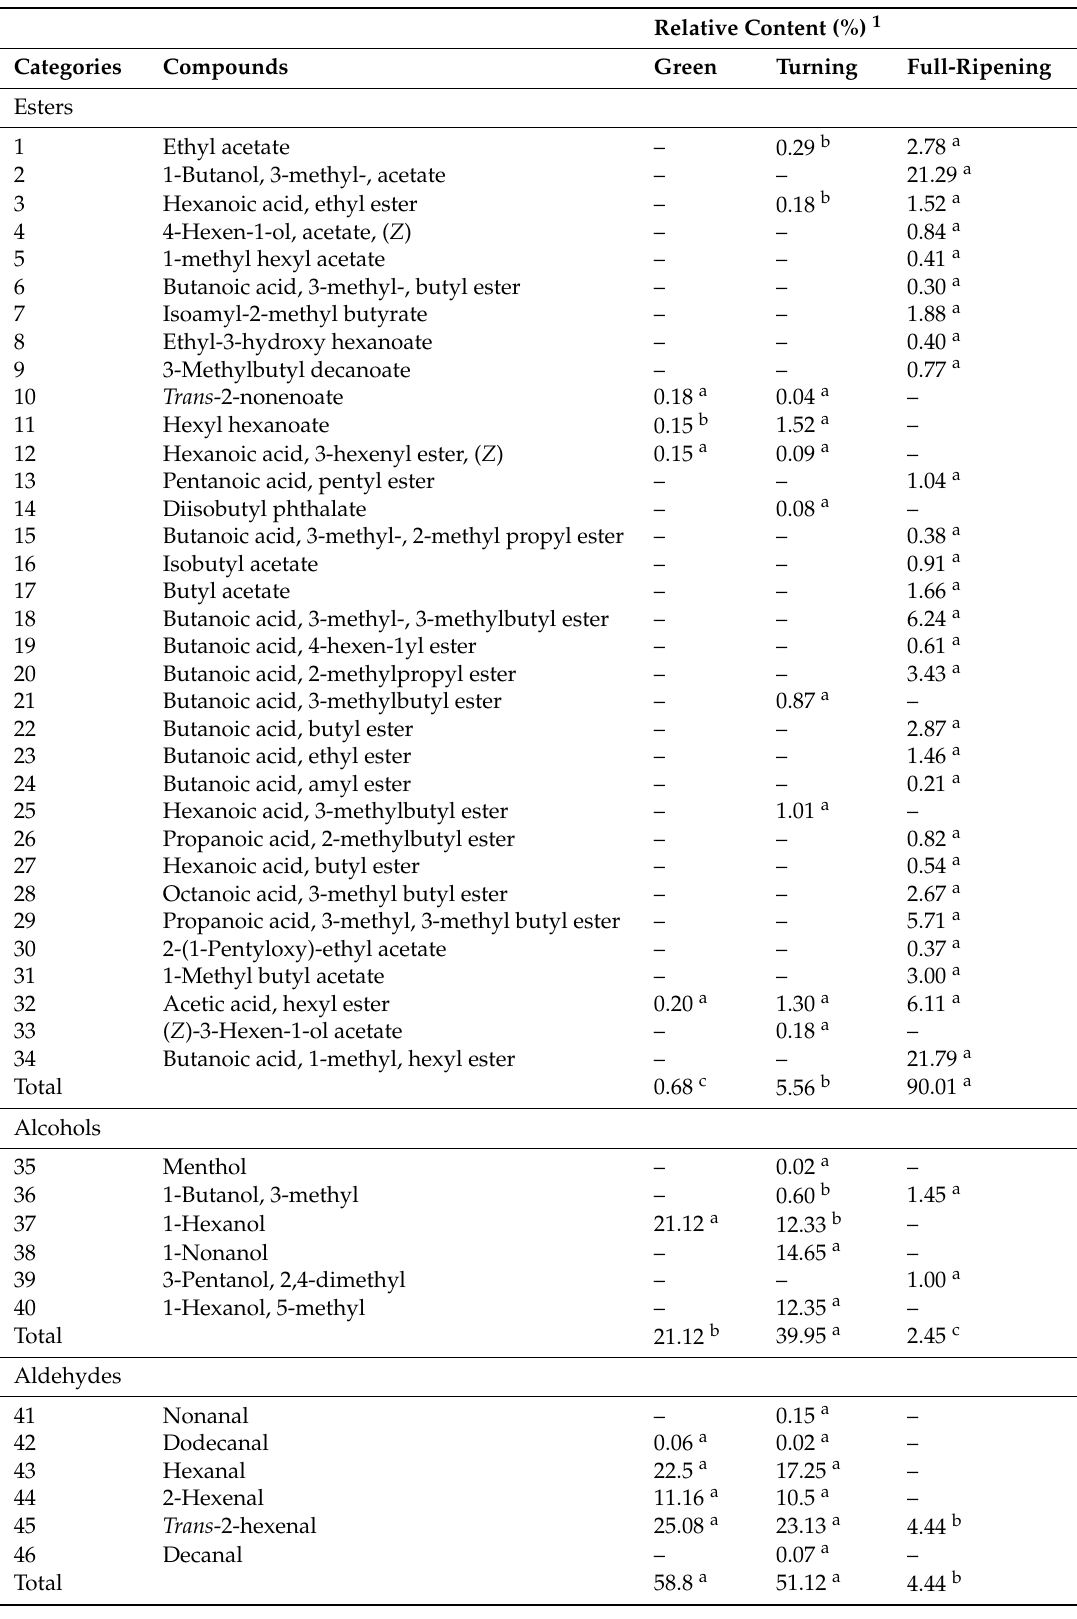
Table 3. Changes in volatiles compounds content in Fenjiao banana fruit at various stages of